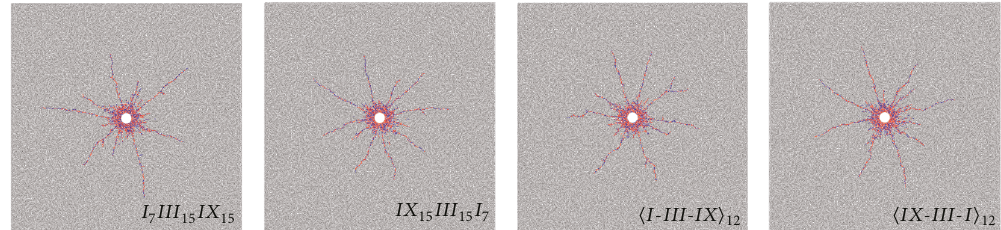
Figure 15: Crack propagation under four groups’ repeated-impacts of HWSWs with different characteristics.